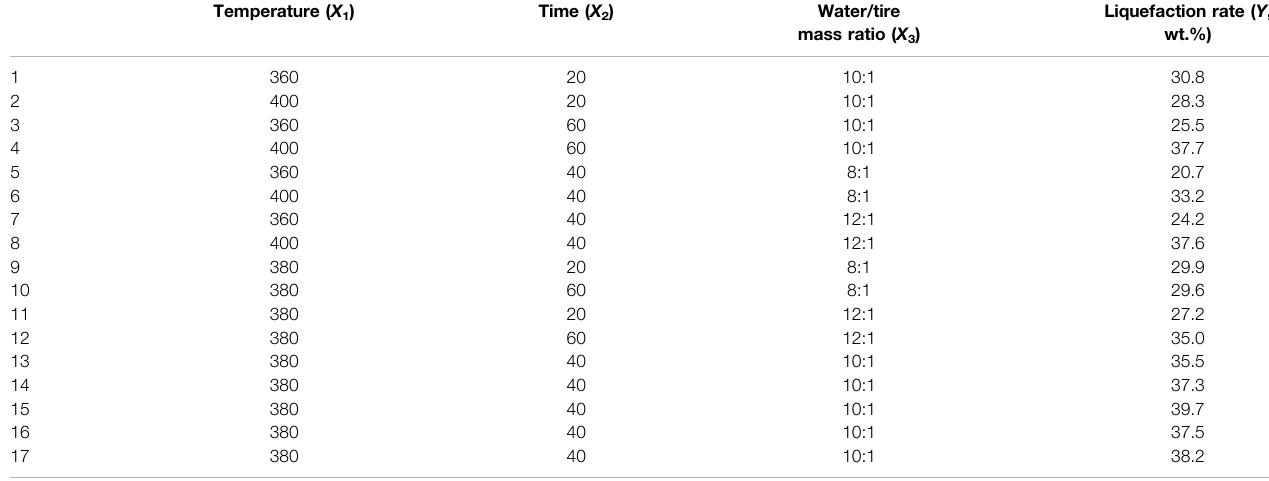
TABLE 1 | The liquefaction rate of tire under different conditions (BBD).